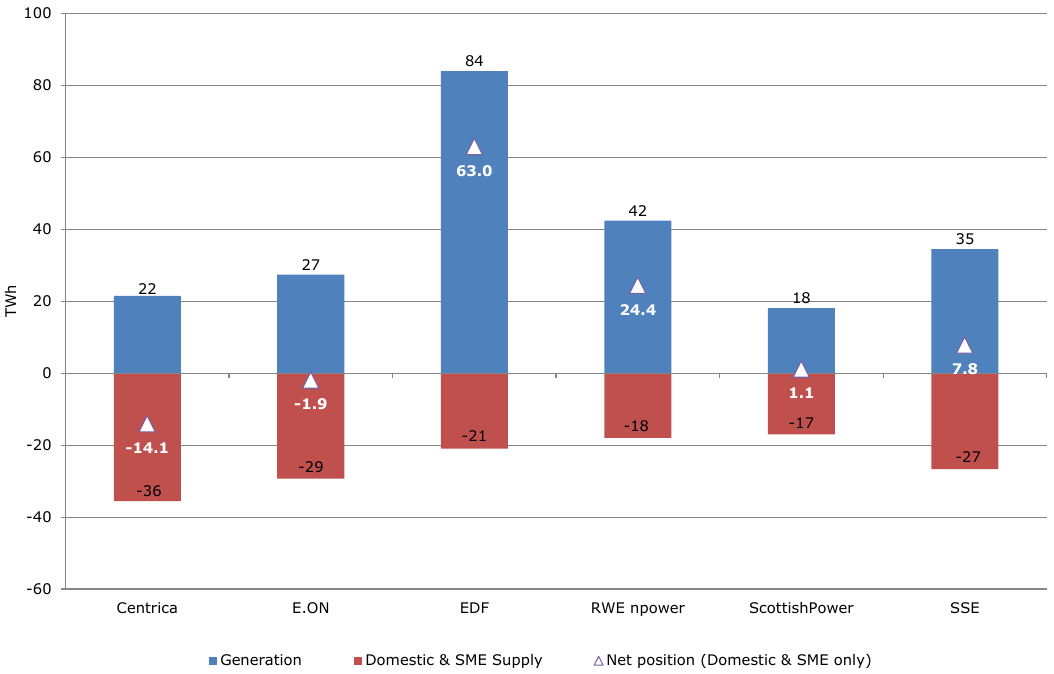
Figure 41: Aggregate balance between GB electricity demand and supply for the six largest energy supply companies for 2012